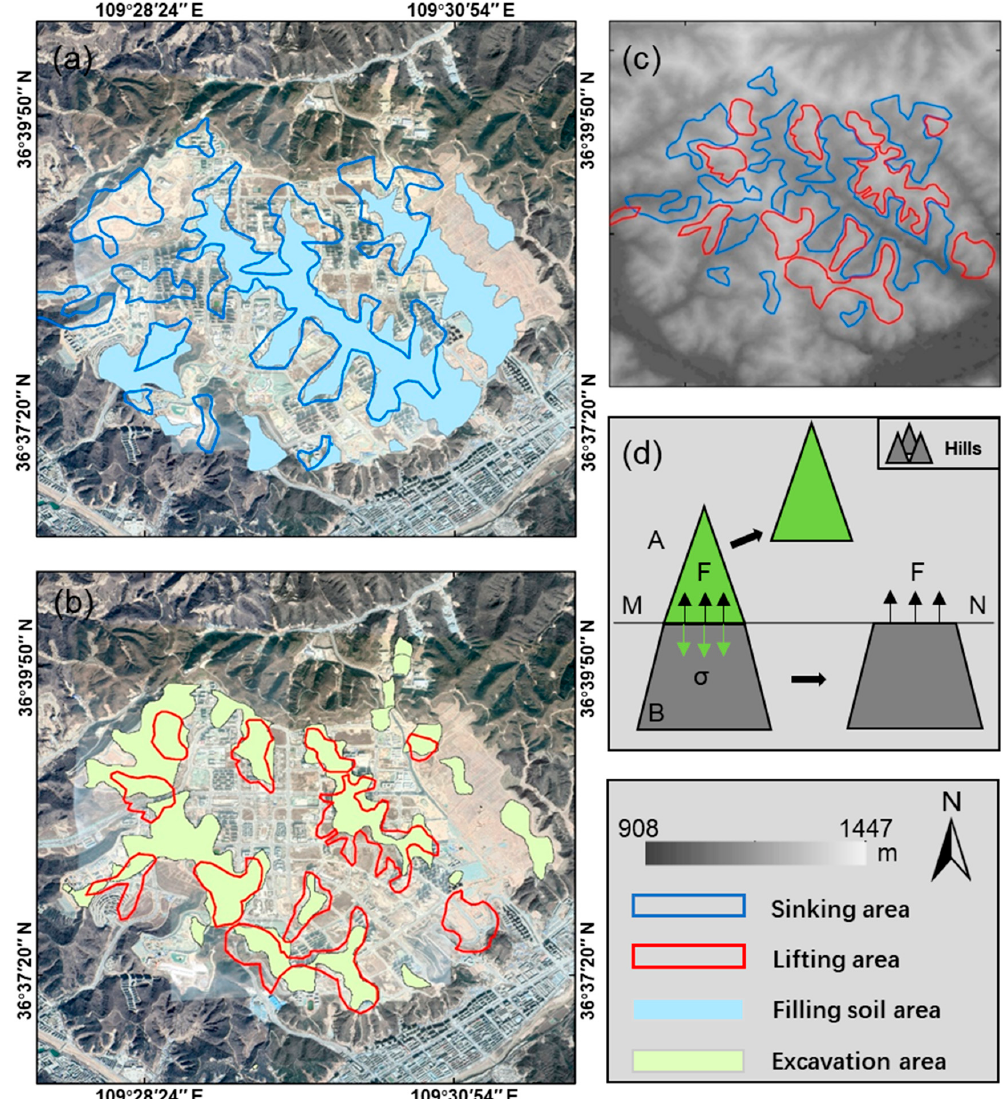
Figure 12. Earthwork region and surface deformation area are superimposed on the Google Earth image. ( a ) Superimposed map of the subsidence area and filling region, ( b ) superimposed map of the uplift area and excavation region, ( c ) location of surface deformation area on DEM, and ( d ) force diagram from when the mountain was excavated.